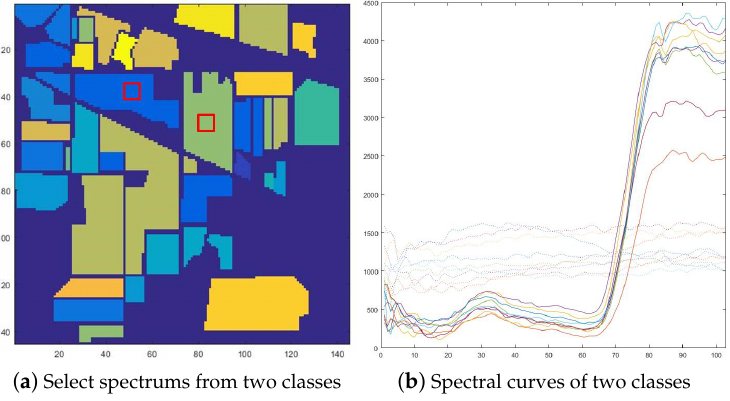
Figure 5. The spectral characteristics of same class and different